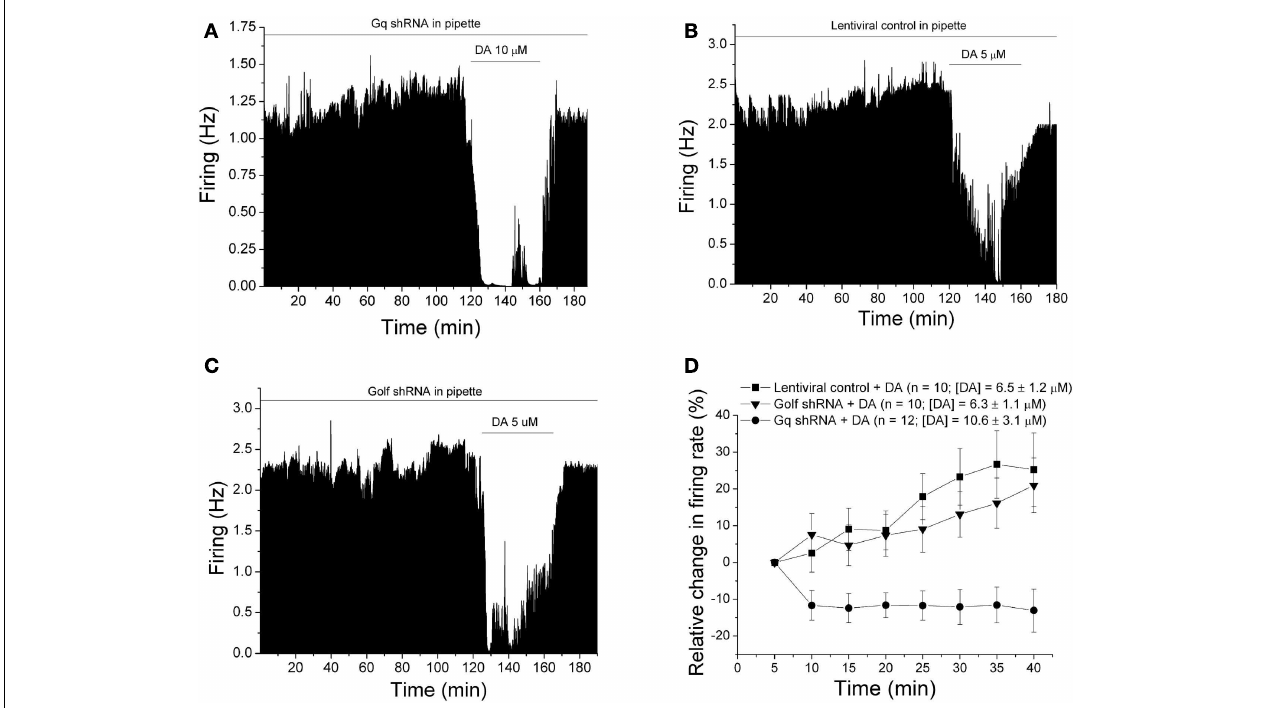
the pipette. No reversal of dopamine-induced inhibition was observed when lentivirus containing Gq shRNA was in the micropipette. (D) Relative change in firing rate (mean ± SEM) is plotted as a function of time. In experiments similar to those shown in parts (A–C) above, the effect of dopamine at each time point was normalized by subtracting the change in firing rate (%) at the 5-min time point.There was a significant reversal in dopamine-induced inhibition when either Golf shRNA ( (cid:72) ) or lentiviral control ( (cid:4) ) was present in the micropipettes. A significant inhibition produced by dopamine was observed with the inclusion of Gq shRNA ( • ) in the